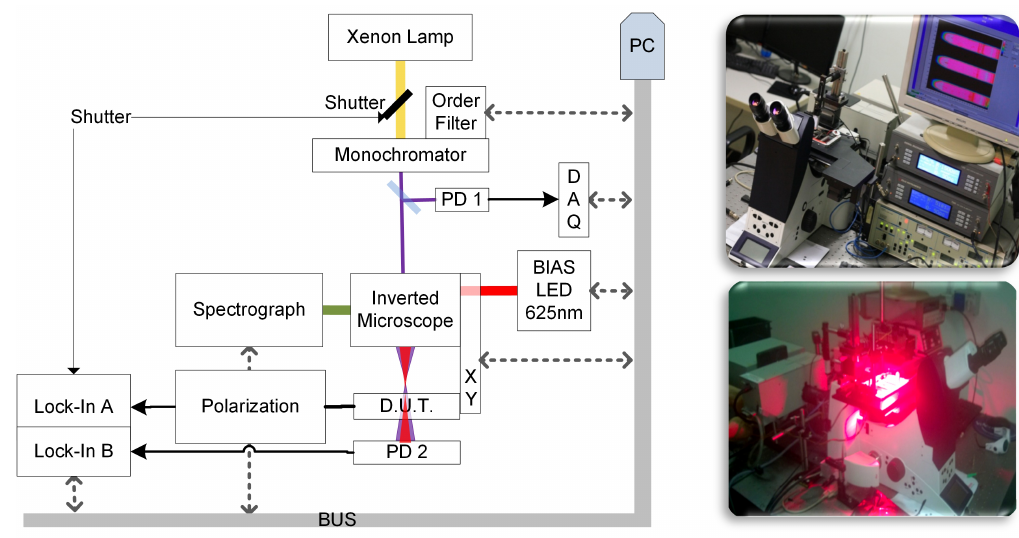
Figure 3. Illustration of the set